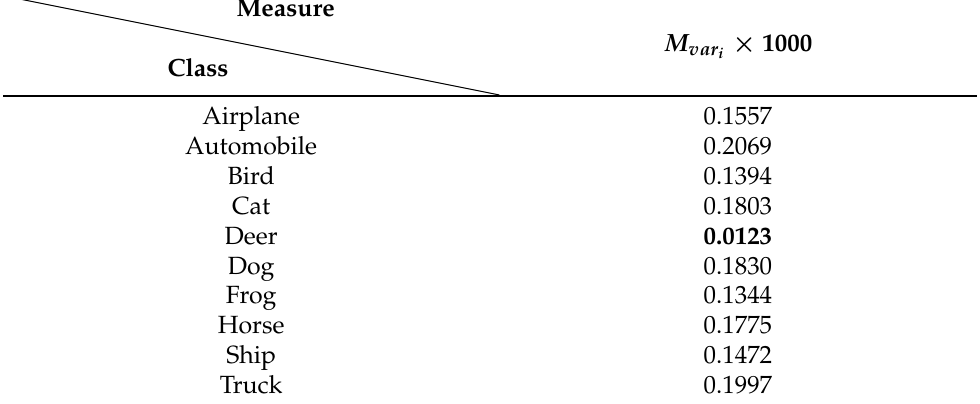
Figure 4. Ten similar selected images in the deer class on degraded-CIFAR10. Images with high similarity were selected using cosine similarity. Table 7. Our in-class variability measure for the degraded-CIFAR10 dataset. A class with a smaller value than other classes has a lower variability.